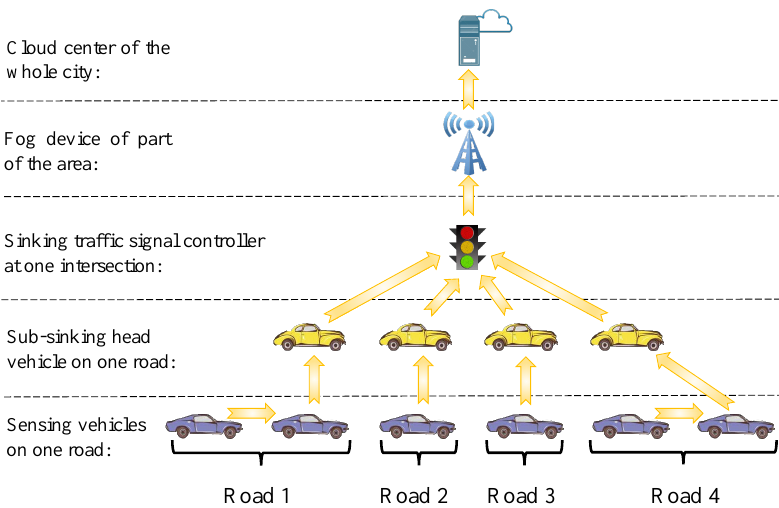
Figure 2. IoVs framework at each intersection j